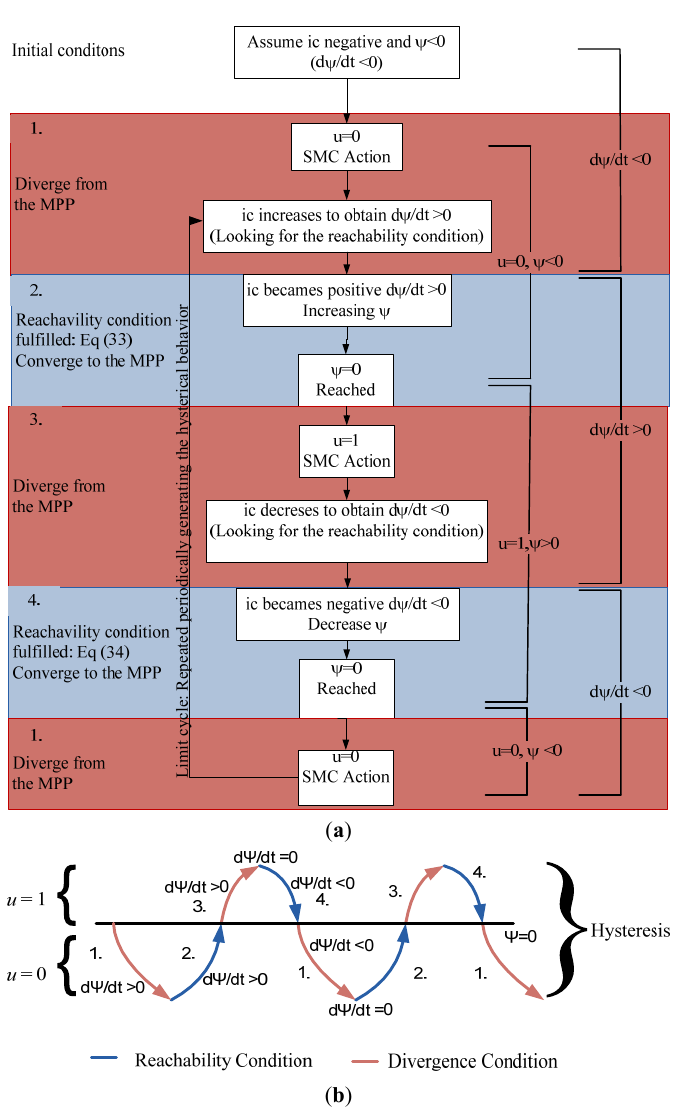
Figure 8. Periodic behavior of the reachability conditions. ( a ) Convergence and divergence conditions; ( b ) Hysteretic behavior.